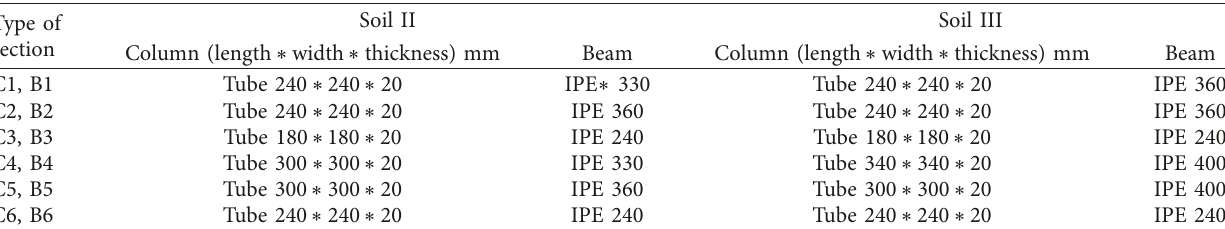
Figure 2: Topology and grouping details of (a) 8- and (b) 5-story frames. Table 2: Designed sections of a 5-story structure.